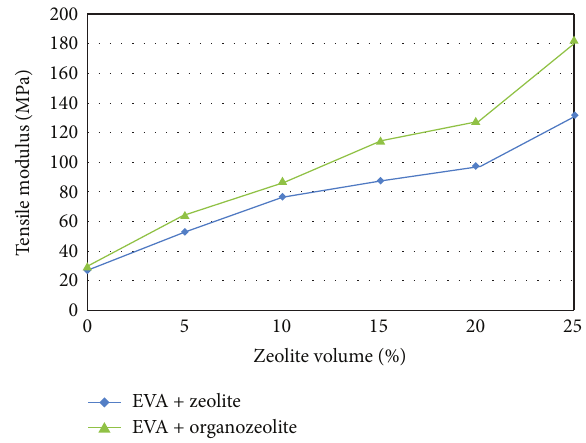
Figure 5: Tensile modulus of zeolite and organozeolite EVA com-